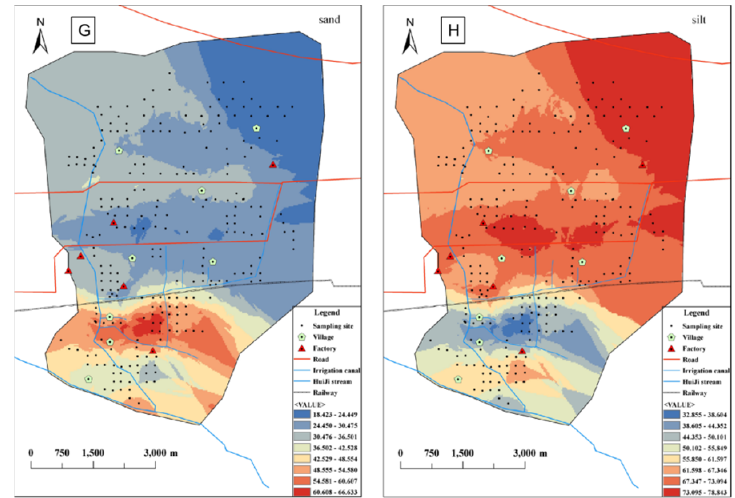
Figure 3. Spatial distribution of total, available Cd contents and soil properties in the topsoils of study area. ( A ) presents the spatial distribution of T-Cd contents in topsoils, ( B ) for A-Cd, ( C ) for pH, ( D ) for SOM, ( E ) for A-P, ( F ) for clay, ( G ) for sand and ( H ) for silt, respectively.